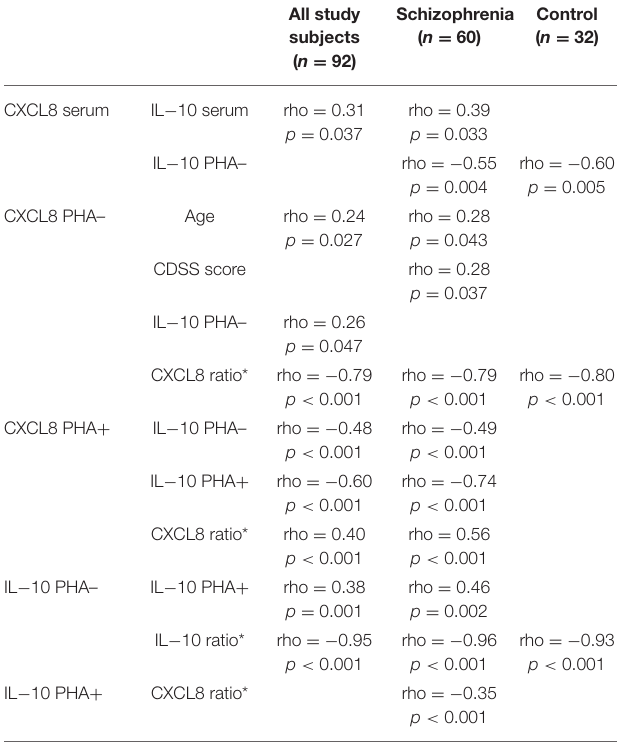
TABLE 5 | Correlations in the study groups.